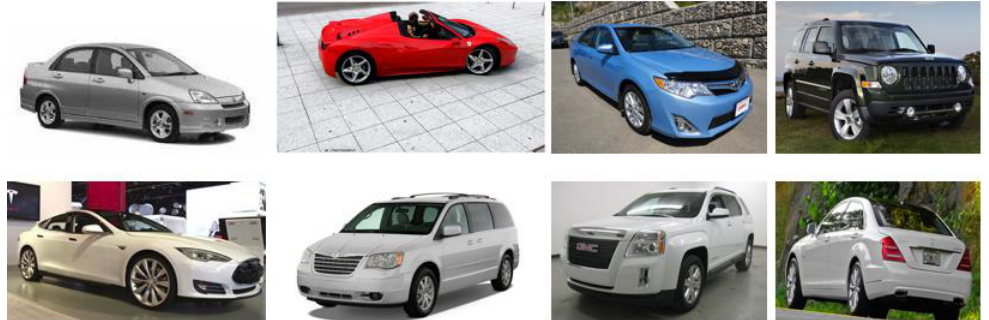
Figure 8. Example of Images from Stanford Cars Dataset [65].